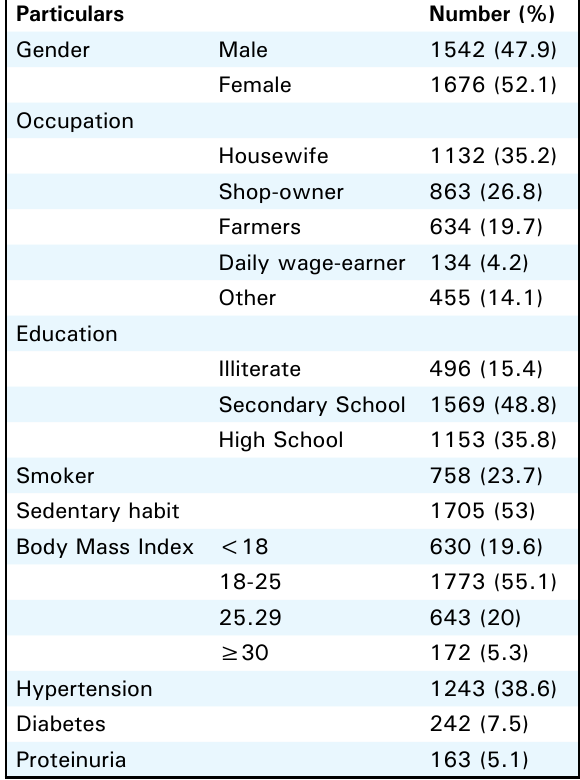
Table 1. Characteristics of the screened